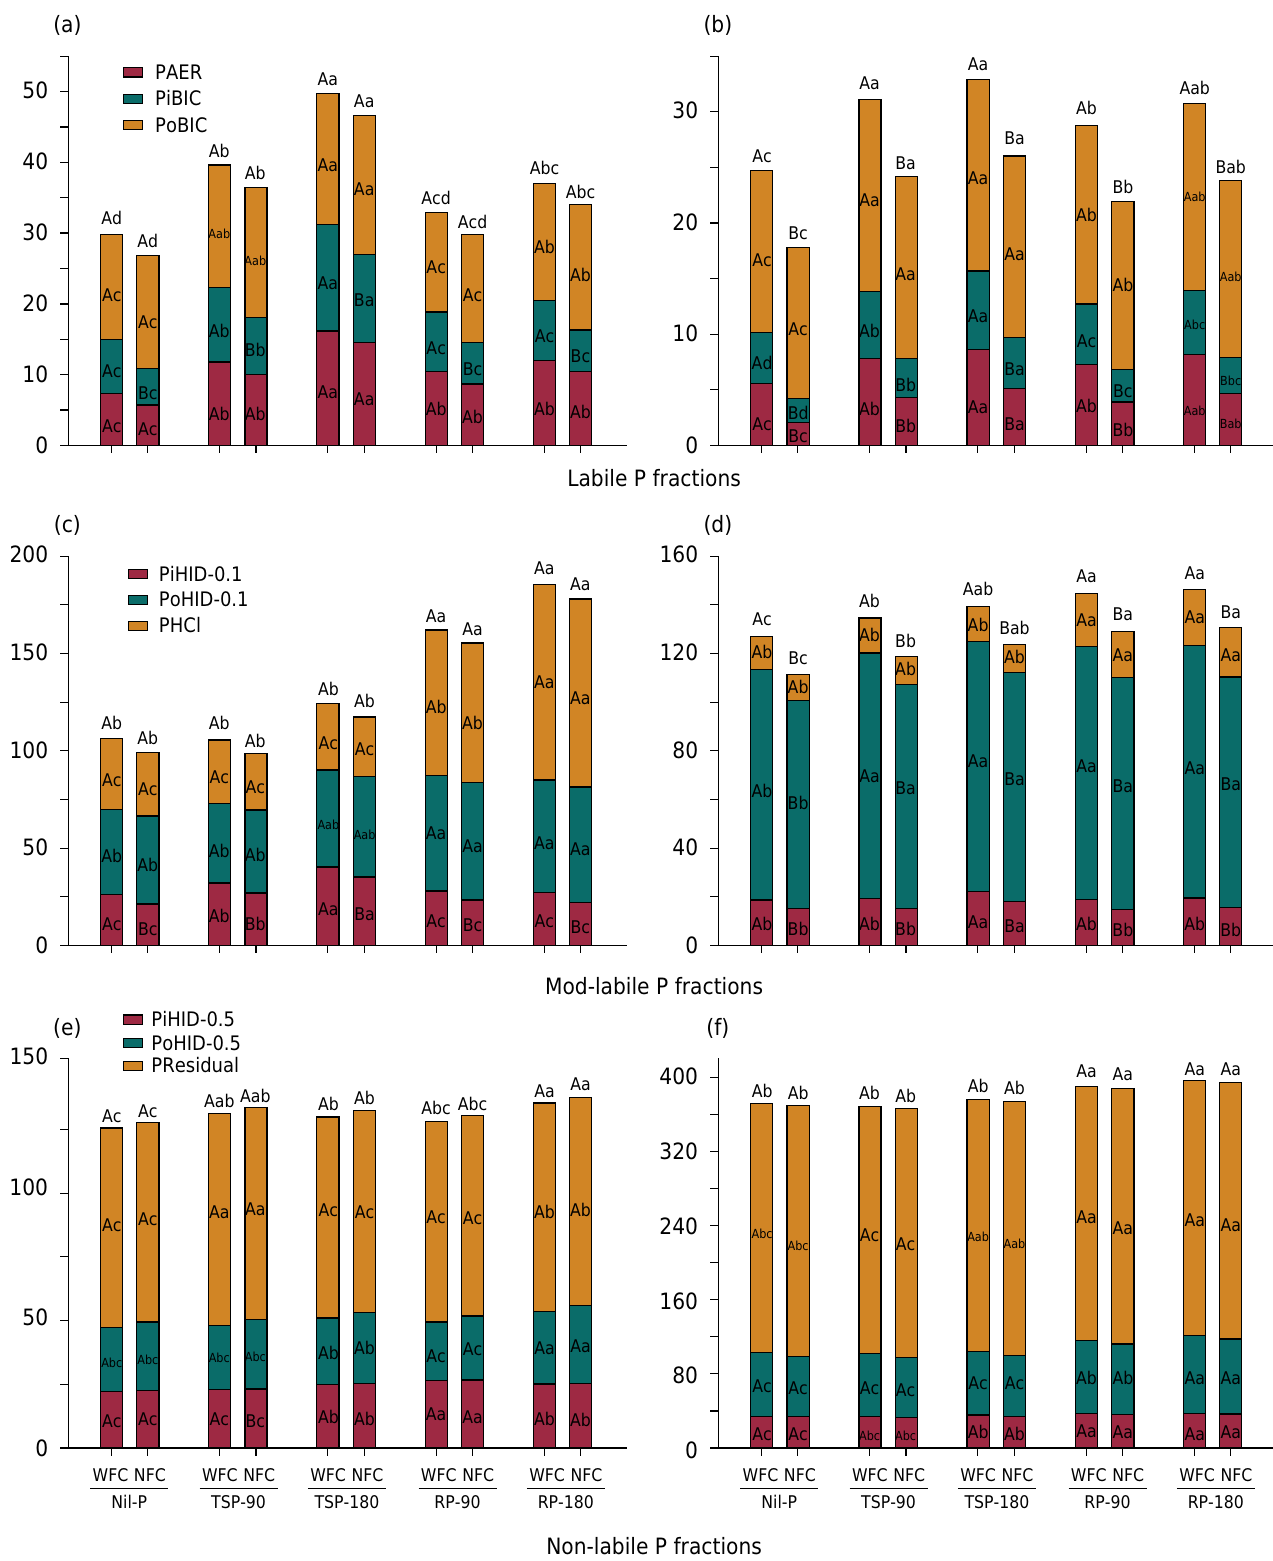
Figure 4. Labile (a), mod-labile (c), and non-labile (e) P fractions at Agudos and labile (b), mod-labile (d), and non-labile (f) P fractions at Macatuba affected by filter cake addition and P sources and rates after two years. Within each fertilizer treatment, means followed by the same capital letter were not significantly different, and within each filter cake treatment, means followed by the same small letter were not significantly different at p<0.05 by LSD